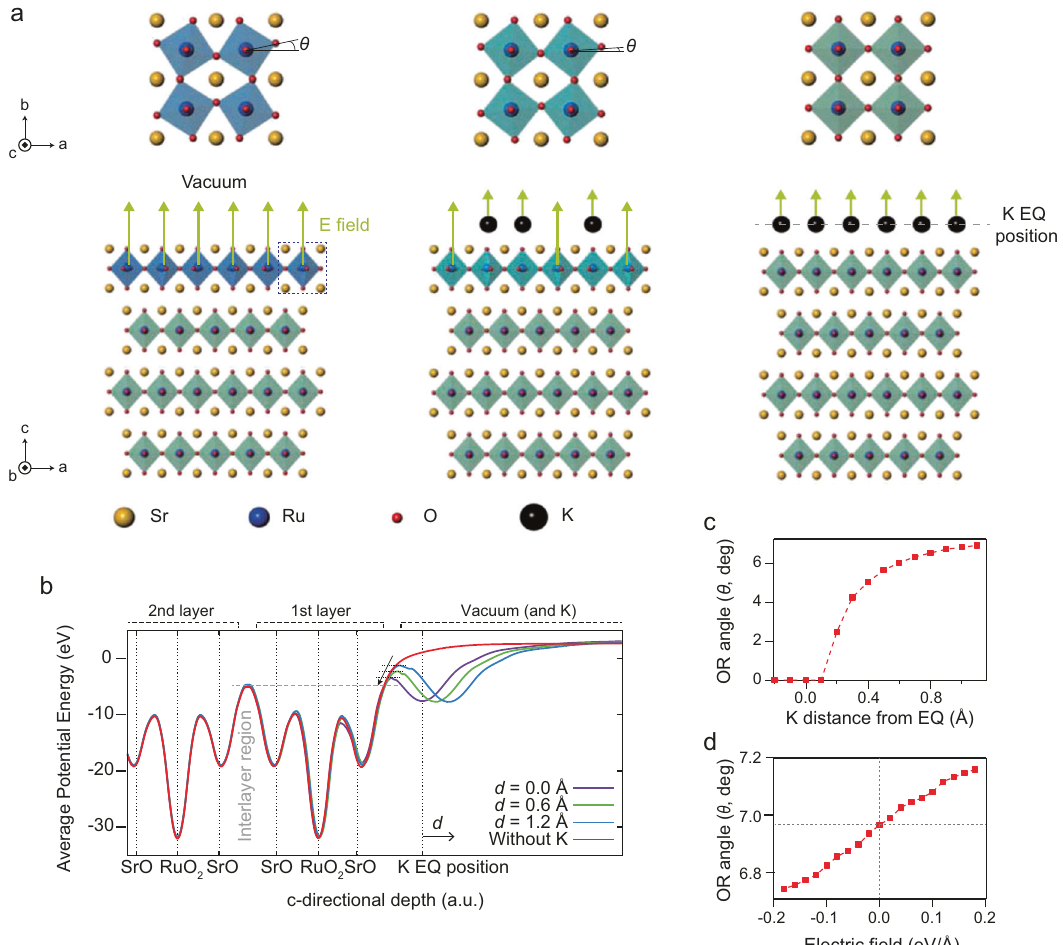
Fig. 3 Electric-potential-driven octahedral rotation (OR). a Crystal structure of Sr 2 RuO 4 with three different K coverages (left: fresh, middle: partial coverage, right: 1 ML). The dashed rectangle marks the area for the enlarged view in Fig. 4a. b – d Density functional theory (DFT) results for a slab of Sr 2 RuO 4 fi ve layers thick. b Electric potential energy as a function of the depth in the c -direction (surface normal), for various K- layer distances from the equilibrium position: d = 0.0, 0.6, 1.2 Å and without a K layer. The equilibrium position of the surface K layer (9.4 Å from the second outermost Ru – O layer) was obtained from the DFT calculation. The gray horizontal dashed line indicates the electric potential energy in the Sr 2 RuO 4 interlayer region. As the K-layer distance decreases, the electric potential in the SrO – K region gradually decreases toward the value of the interlayer region (black arrow). c Plot of OR angle as a function of the K-layer distance from the equilibrium position. d Plot of OR angle as a function of electric fi